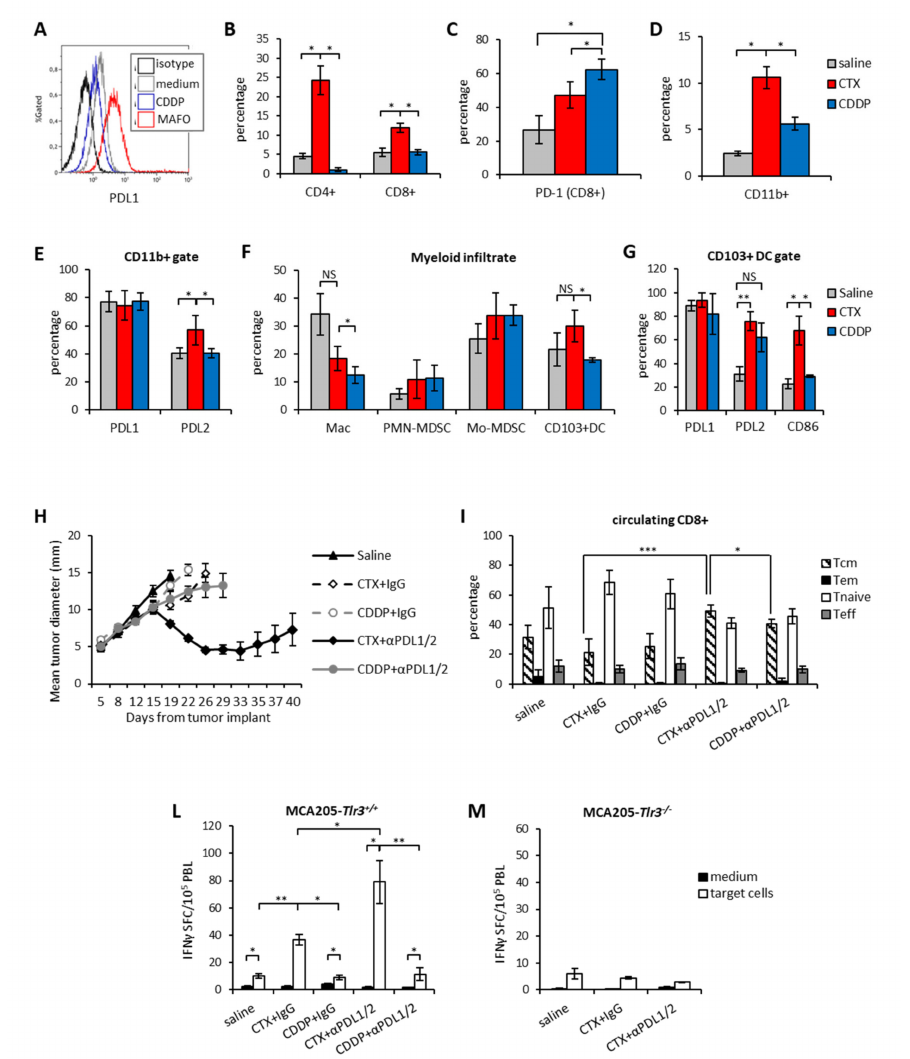
Figure 5. CTX,butnotCDDP,pre-treatmentsynergizeswithPDL1 / 2blockadein vivo. (A) Surfaceexpression of PDL1 on MCA205 tumor cells treated in vitro for 24 h with mafosfamide (15 µ g / ml, MAFO) or cisplatin (CDDP) or with medium as control. One representative experiment out of two is